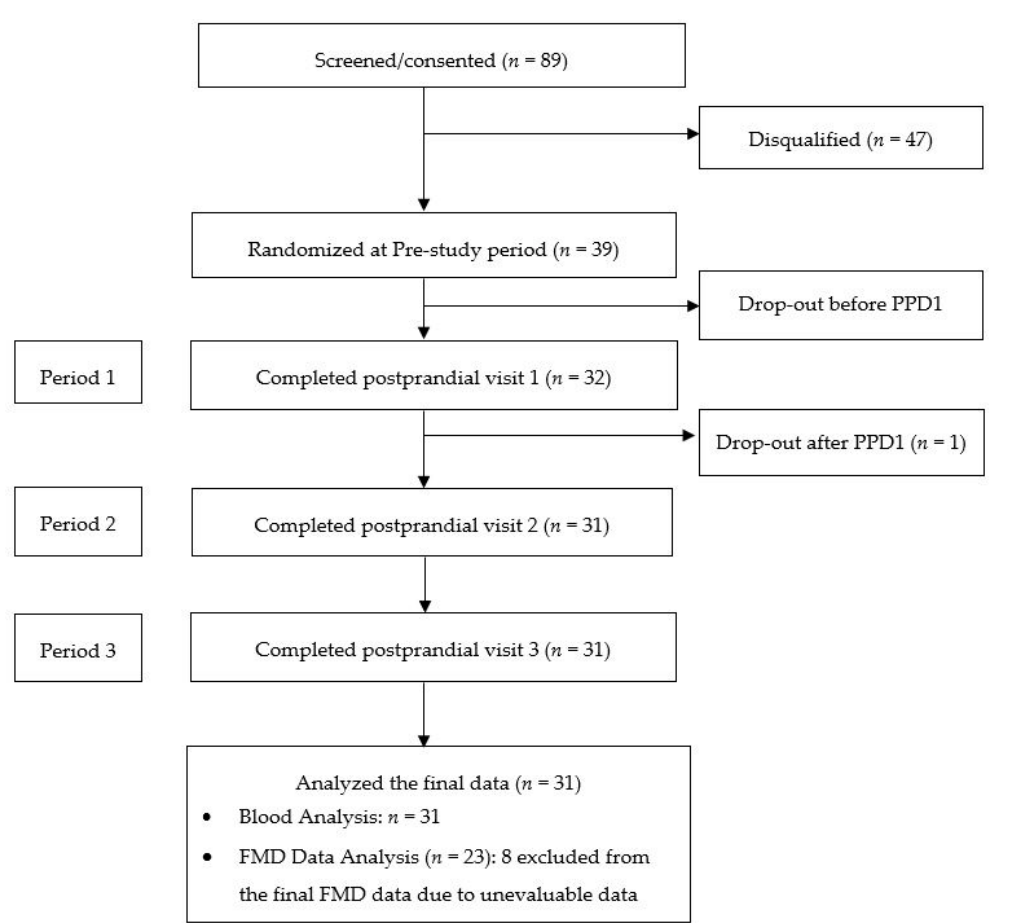
Figure 1. Consolidated Standards of Reporting Trials (CONSORT) flow diagram of the study. PPD, Postprandial study day; FMD, Flow mediated vasodilation.